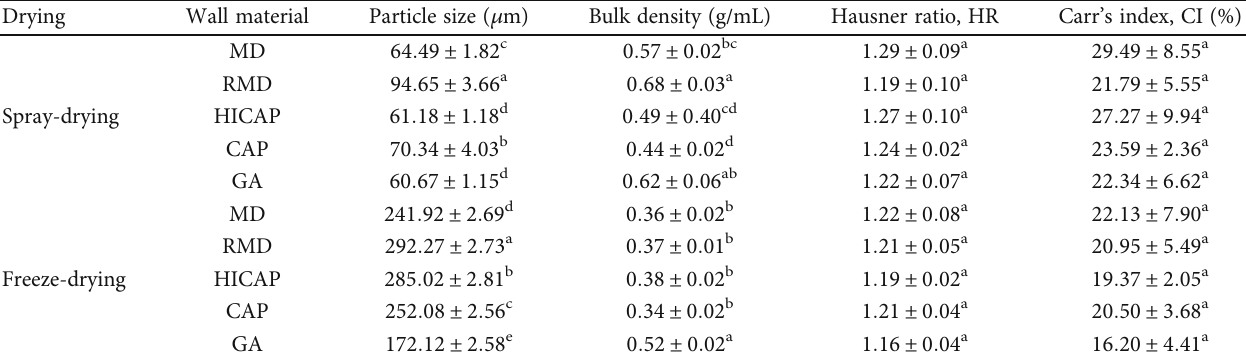
Data are expressed as the means ± standarddeviations of triplicates. Means with the same letter in each column mean not signi fi cantly di ff erent ( p < 0 : 05 , Tukey test). MD: maltodextrin; RMD: resistant maltodextrin; HICAP: HI CAP 100; CAP: Capsul; GA: gum